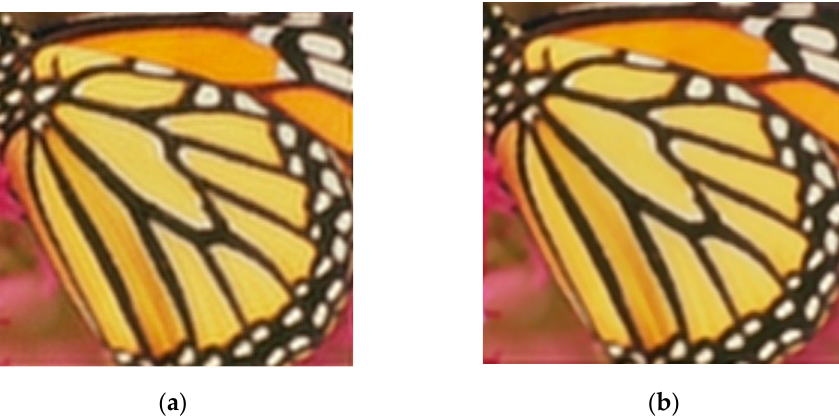
kernel disappear gradually in the iterative process.